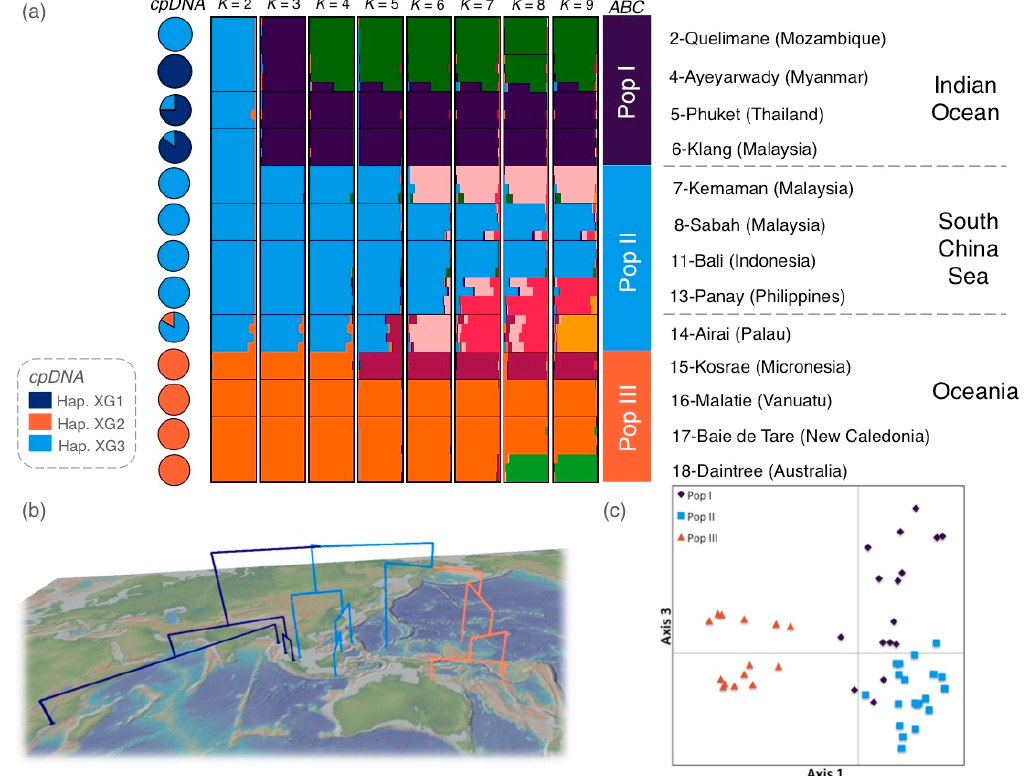
Figure 3. Bayesian clustering analyses of nuclear simple sequence repeat (SSR) data for the 18 populations of Xylocarpus granatum J. Koenig. ( a ) Bar plots indicating the putative genetic ancestry of each individual in comparison with the cpDNA haplotype composition of each population. ( b ) Population neighbor-joining (NJ) tree reconstructed on a topographic map. Each branch was colored based on the population subdivision used for approximate Bayesian computation (ABC) analyses (Pop I: orange, Pop II: blue, and Pop III: green). ( c ) Plot of the second two coordinates of principal coordinates analysis (PCoA) based on the SSR data. Samples were colored according to the subdivision used for ABC analyses.